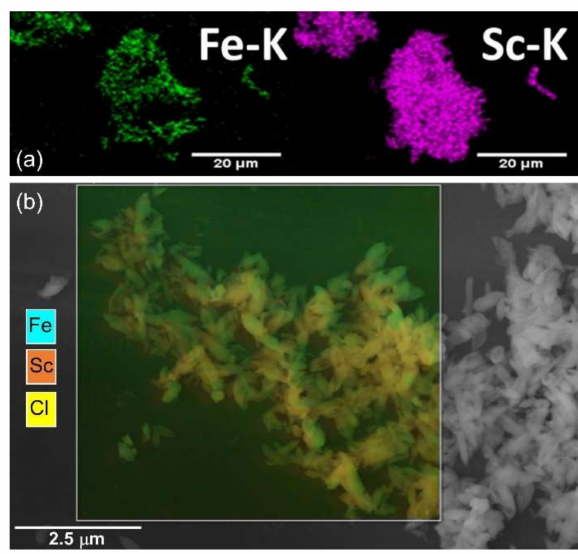
Figure 6. Elemental maps of MIL-88B(Fe 0.5 Sc 0.5 ) at two magnifications showing the distribution of the two metals, and the presence of